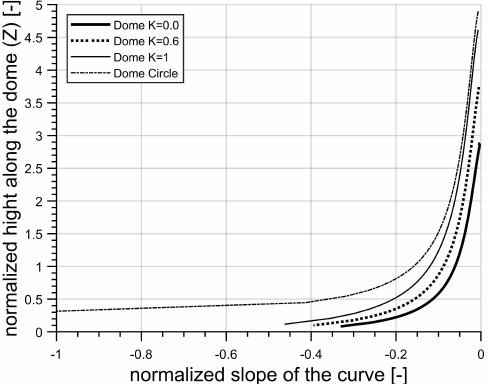
Figure 12. Normalised slopes for varying K values.